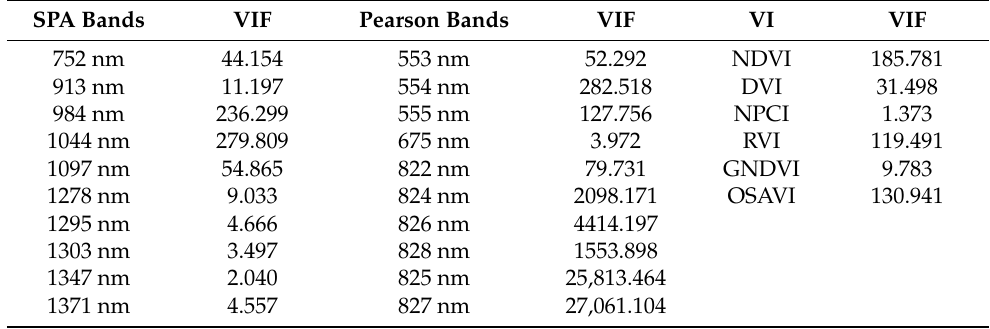
Table 3. Results of VIF test for the whole fertility period of characteristic bands and vegetation indices.